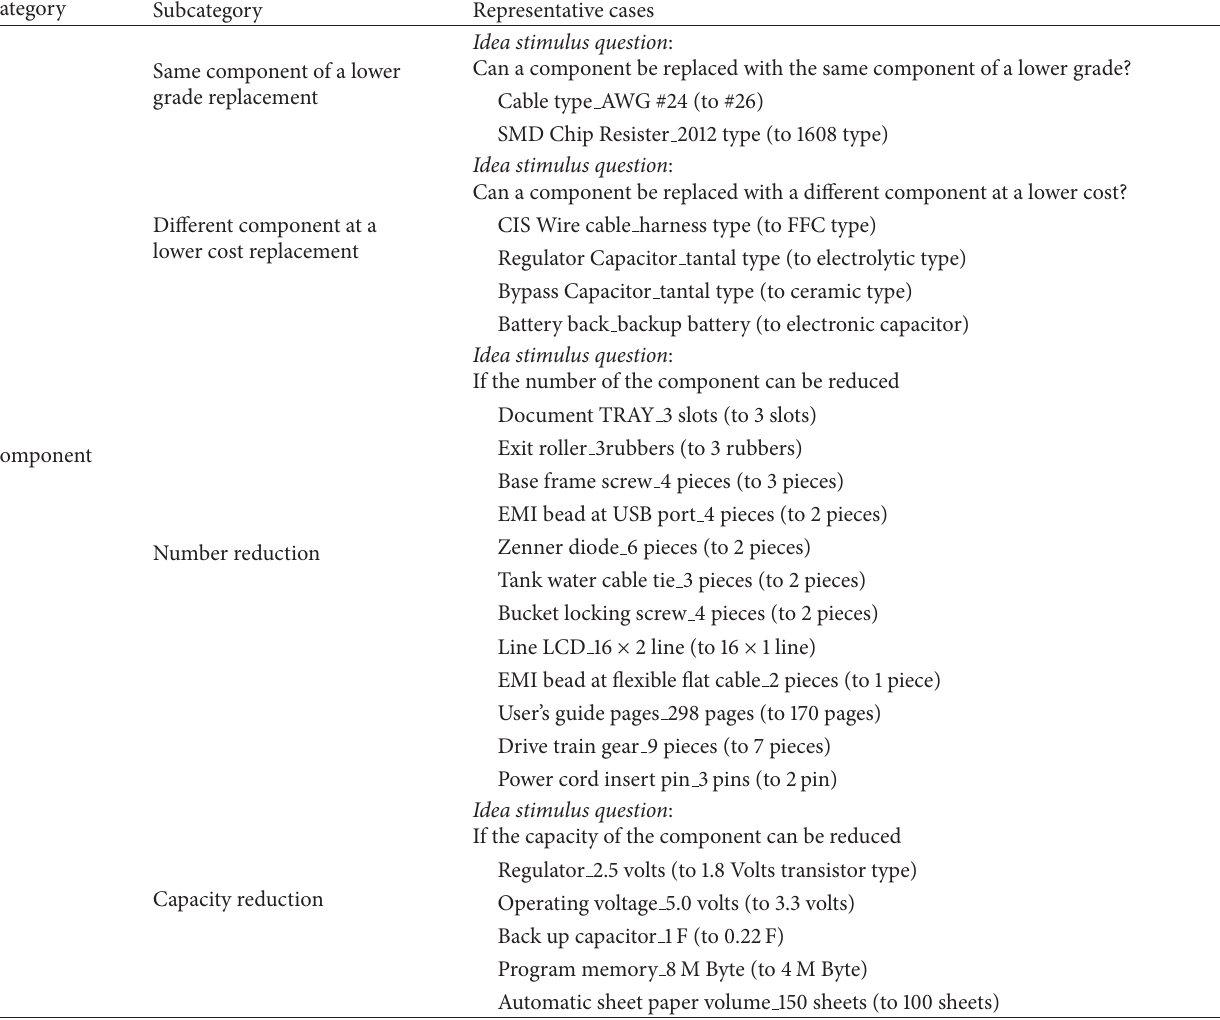
Table 5: Component checklist and representative cases.